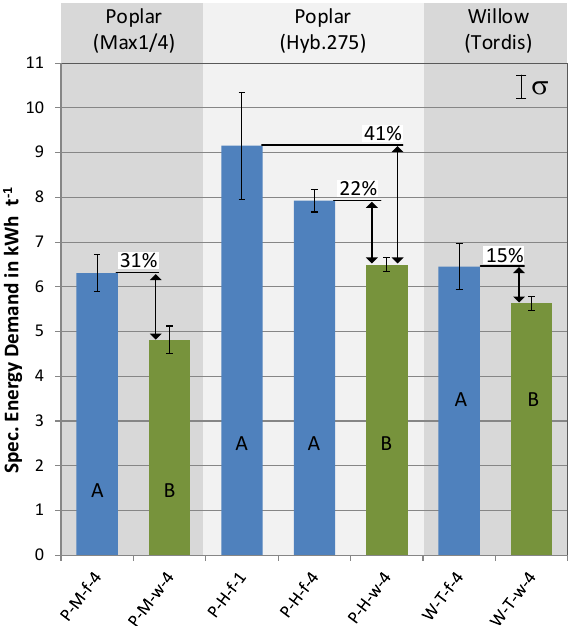
Figure 6. Overview of the specific energy demand for chipping poplars, willows and black locusts from short rotation coppices (SRCs) in fresh, dried and frozen conditions (colors: green = fresh, dried = red, blue = frozen); Labelling of trials on x-axis: Variety-Clone-Condition-No of shoots per trial. Example for labelling: W-S-d-15 = W illow, clone S alix viminalis , d ried shoots, 15 shoots per chipping trial, see Table 1.